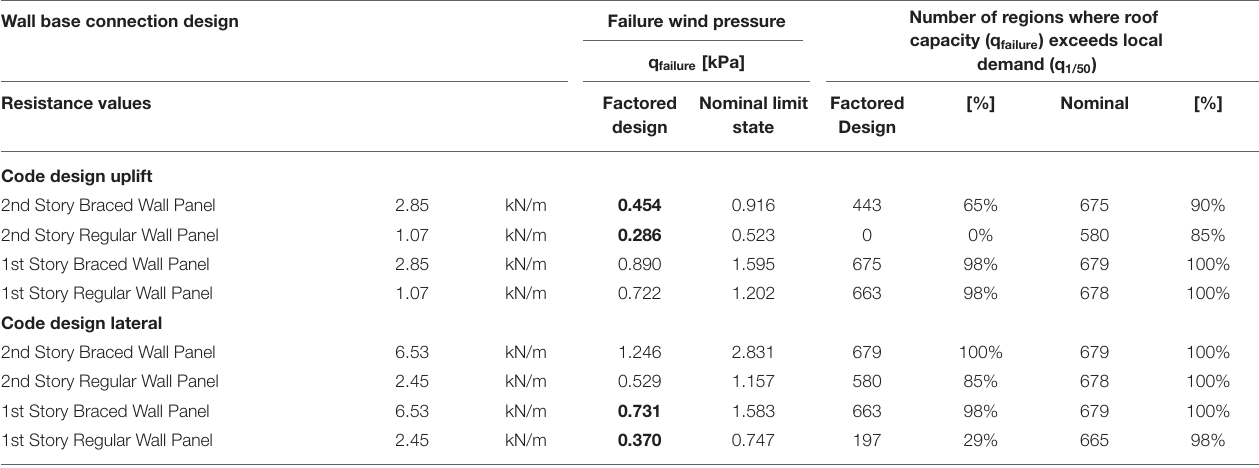
TABLE 6 | Design check for wall anchorage showing factored and unfactored design wind pressures, adjusted for suburban terrain, for uplift and lateral load effects, as well as a comparison to the design wind pressures in NBCC (Canadian Commission on Building and Fire Codes, 2015) climate